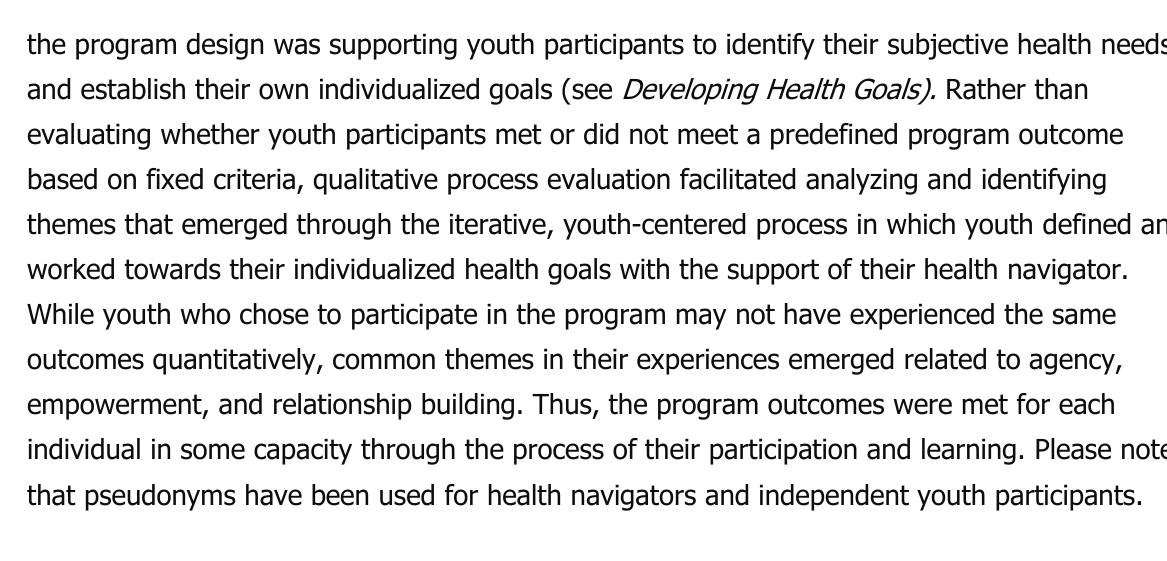
Table 2. Themes Presented According to Program